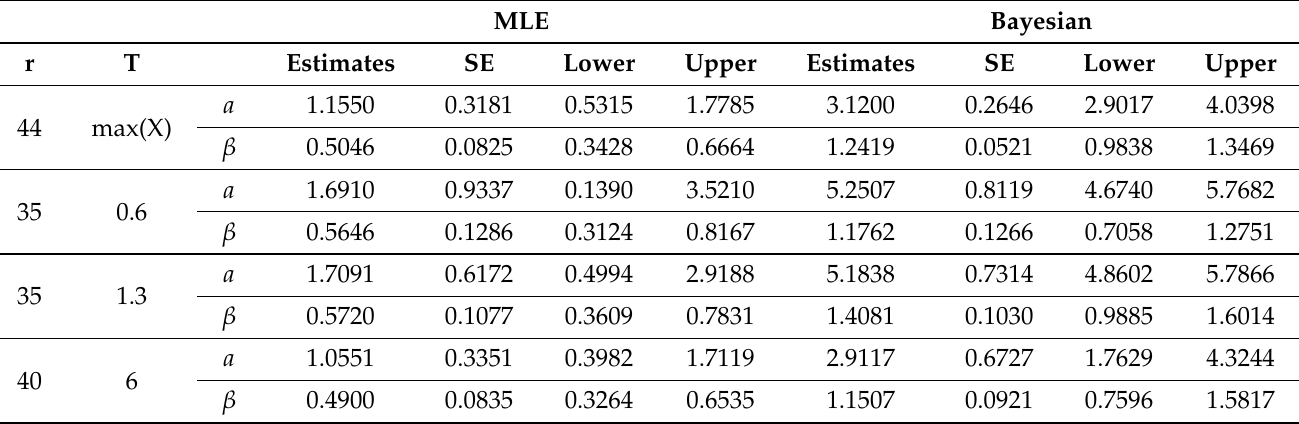
Table 8. MLE and Bayesian estimation for TCP-ITL based on hybrid censored samples: Data